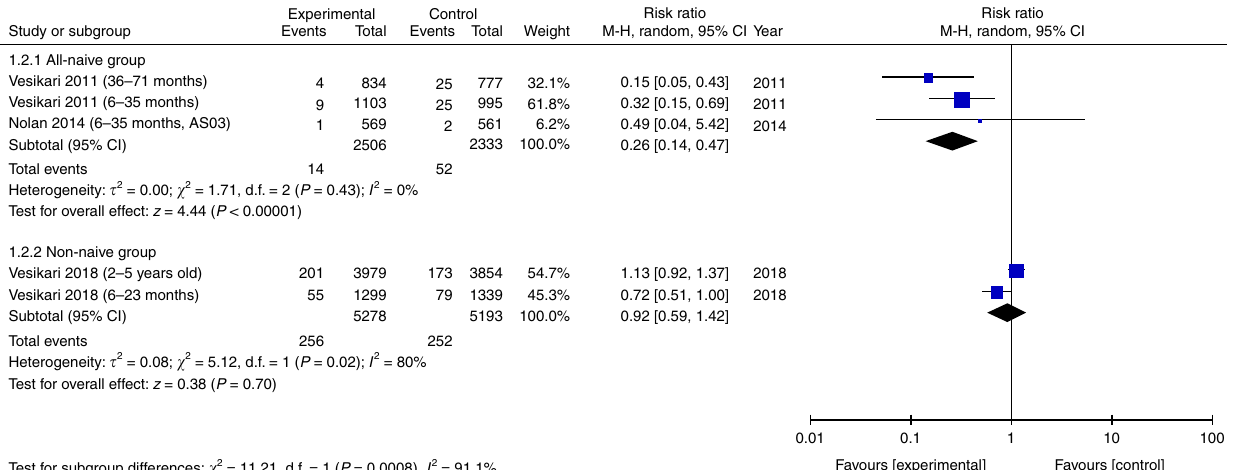
For seroprotection against in fl uenza B, adjuvanticity was less impressive after the fi rst dose in poor response group (Supple- mentary Fig. 5). Only after the second dose, adjuvanted vaccines were signi fi cantly better than non-adjuvanted counterparts in poor response group (weighted RR: 5.4; 95% CI: 3.8 – 7.5; I 2 : 24%)